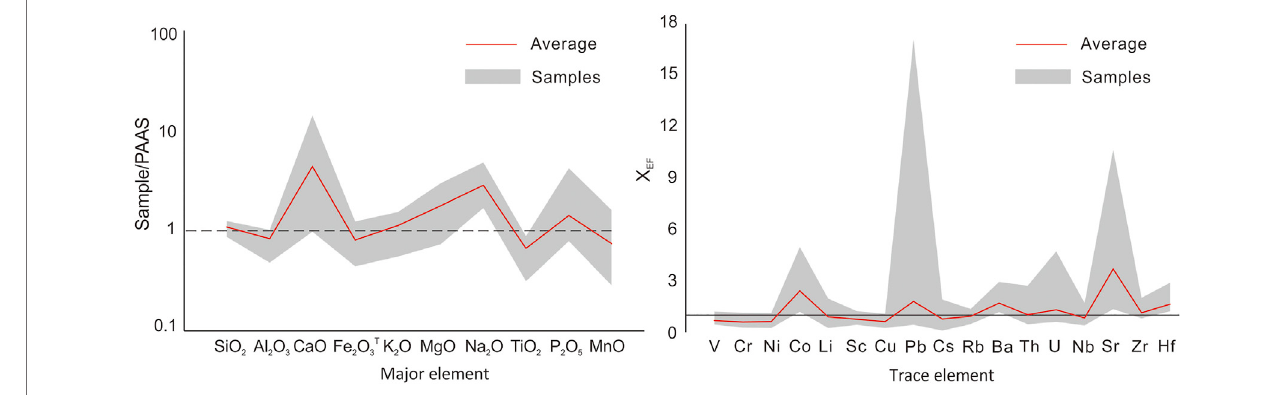
FIGURE 3 | Major elements and XEFof trace elements.